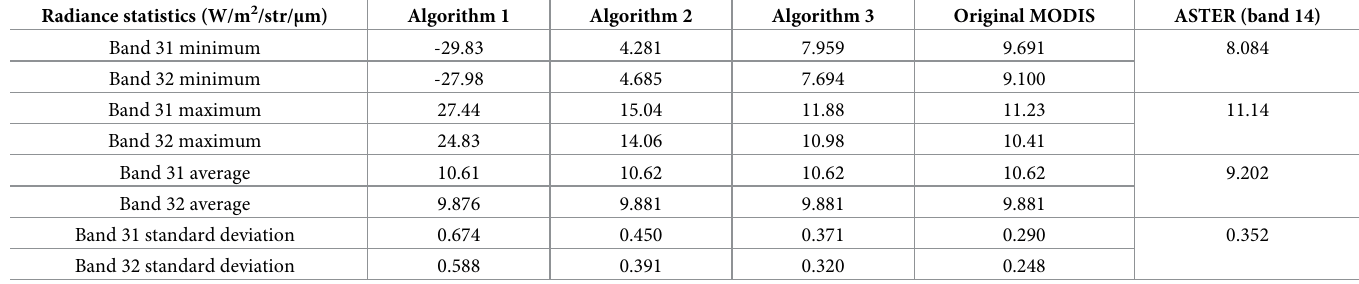
Table 3. Basic statistics over the entire study region between the results from the three super-resolution algorithms, original MODIS image (1-km resolution), and ASTER image. Radiance statistics (W/m 2 /str/ μ